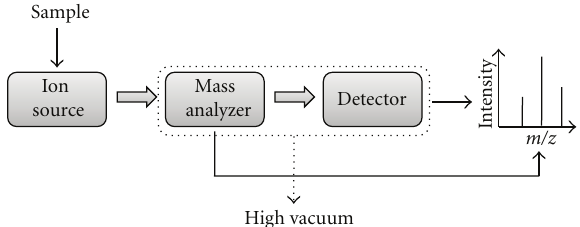
Figure 2: The basic components of the ESI-mass